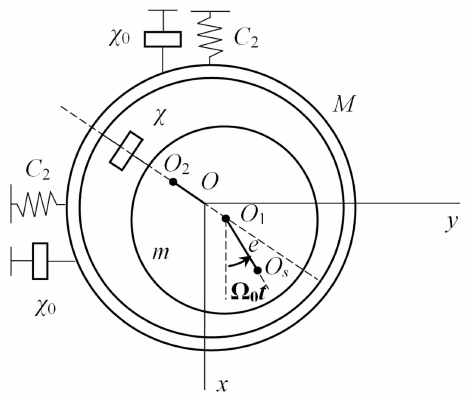
Figure 1. Rotor system on rolling